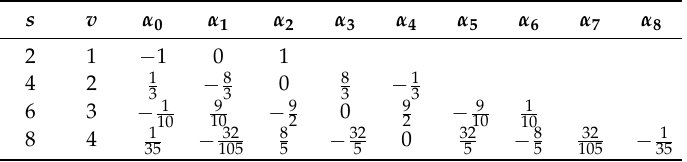
Table 3. The coefficients of central difference schemes using uniform